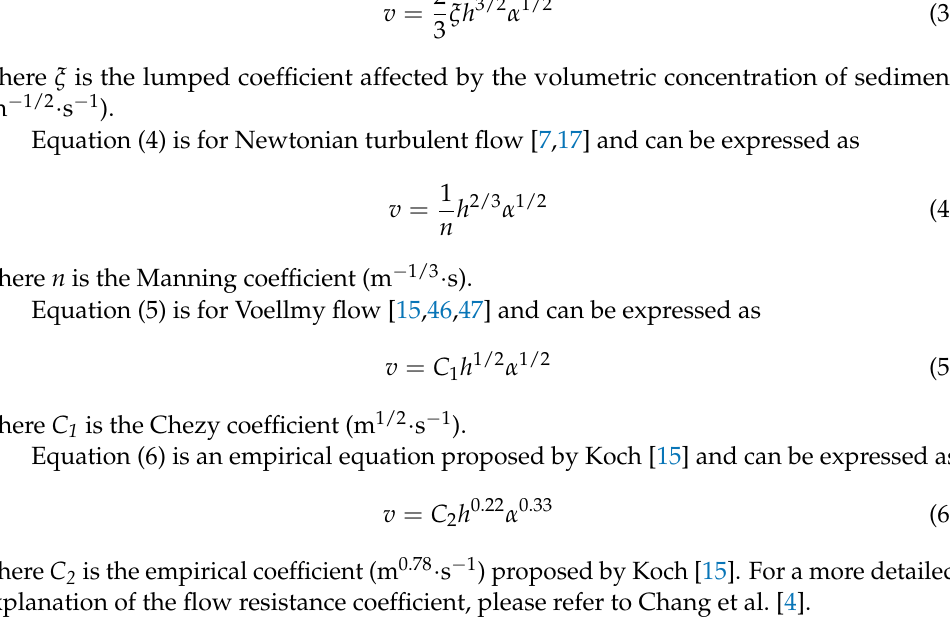
Figure 5. Examples of laboratory tests: ( a ) Example of a straight channel test ( α = 20° and C V = 0.50); and ( b ) example of a single-berm channel test ( α = 20° and C V = 0.50).